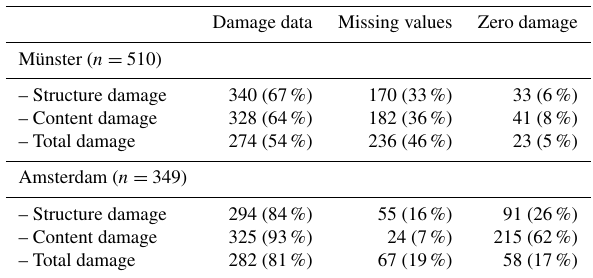
Table 4. Number of respondents providing loss